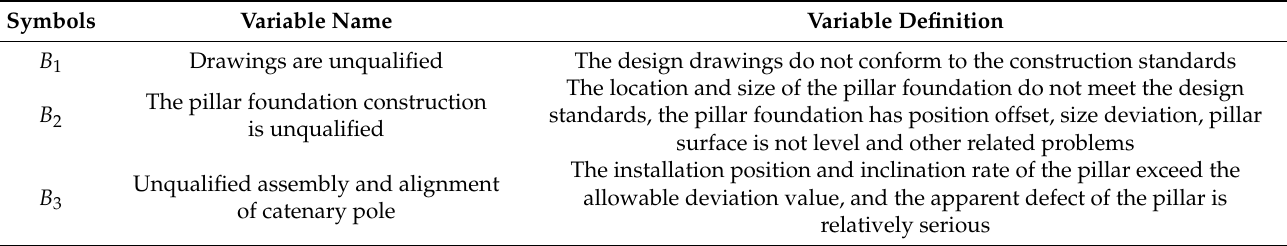
Table 2. Endogenous variables of catenary construction